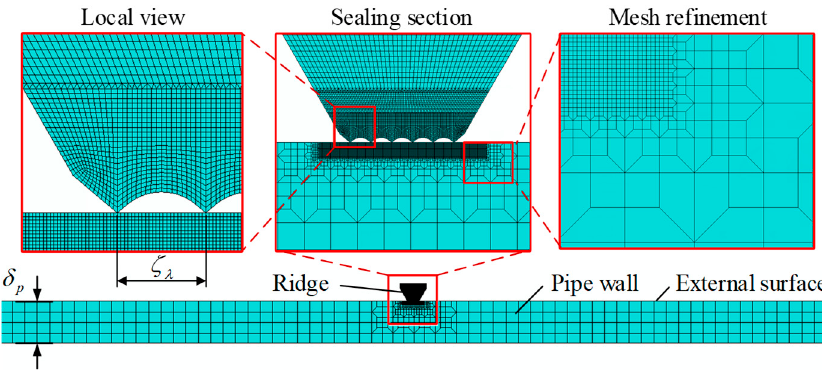
Figure 7. The mesoscale 2D axisymmetric FE model of the seal and local mesh views.